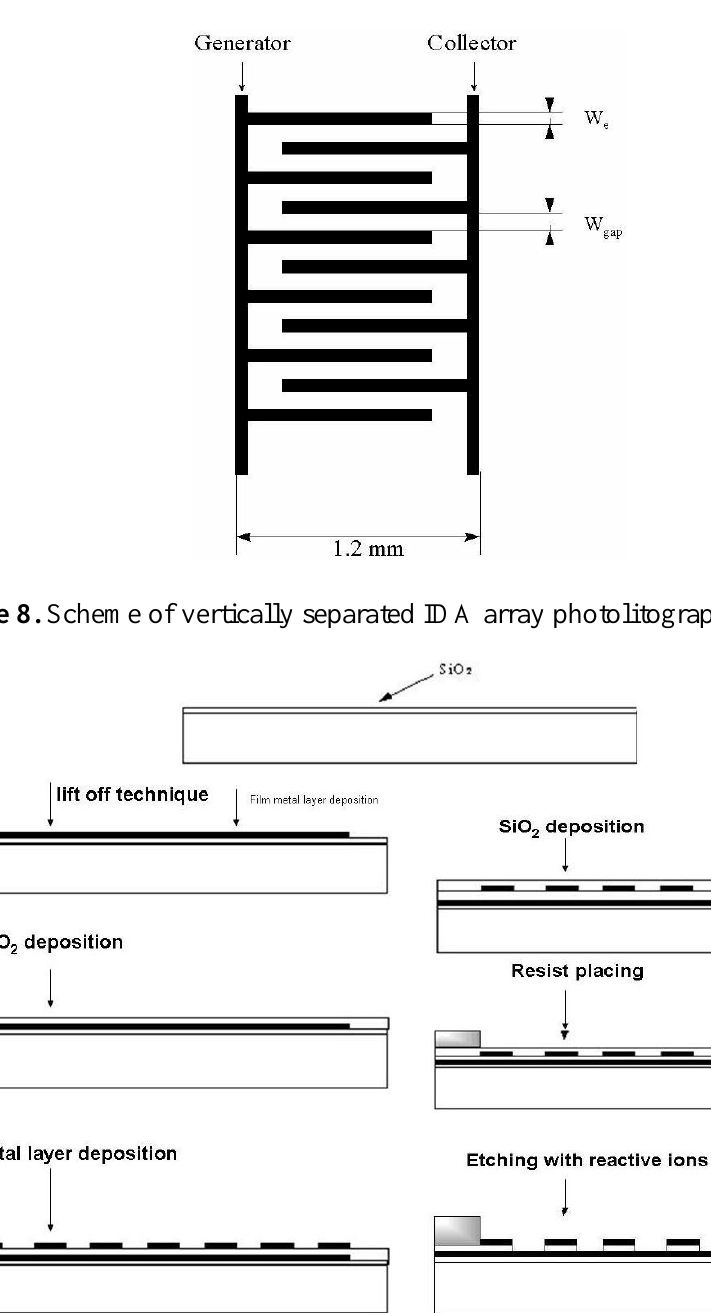
Figure 7. Horizontally separated IDA array [55].